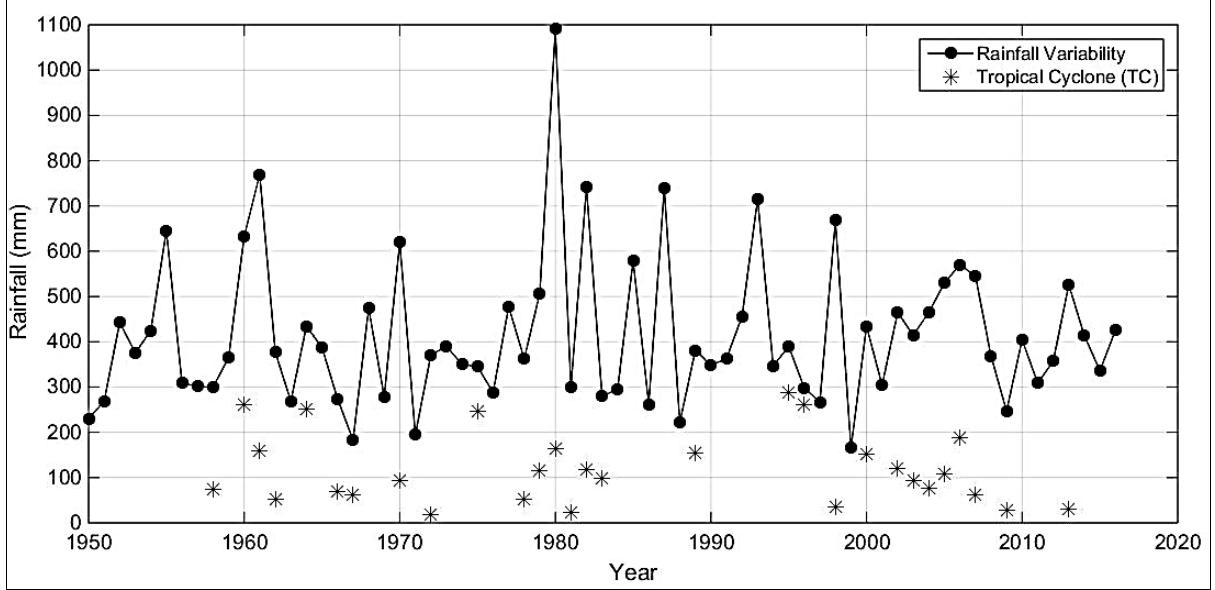
Figure 2: Yearly range (maximum minus minimum) of mean monthly rainfall over Mauritius during the 1950–2016 period. The asterisks indicate the occurrence of tropical Table 1: Characteristics of data used in the study Statistic Estimate